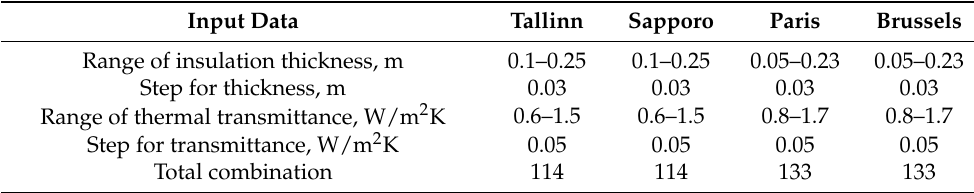
Table 2. Input data of parametric run for a single floor and a whole building model.